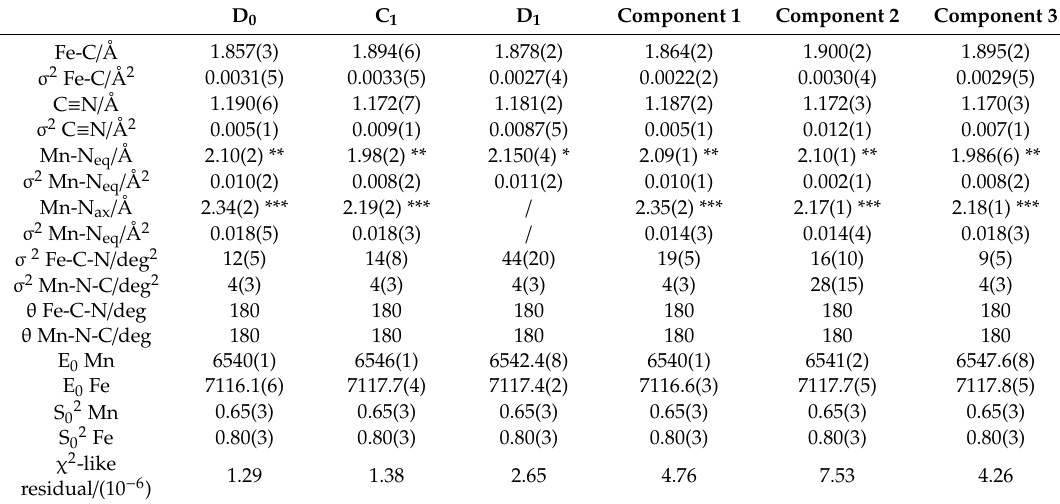
Table 1. Relevant extended X-ray absorption fine structure (EXAFS) refined parameters for the D 0 , C 1 , and D 1 states of charge, as well as the three components retrieved by the MCR-ALS analysis. D 0 C 1 D